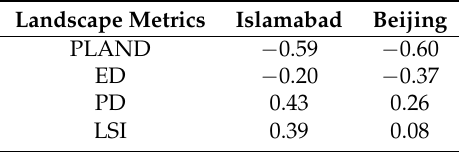
Table 8. Pearson’s correlation between landscape metrics and LST for Islamabad and Beijing. Landscape Metrics